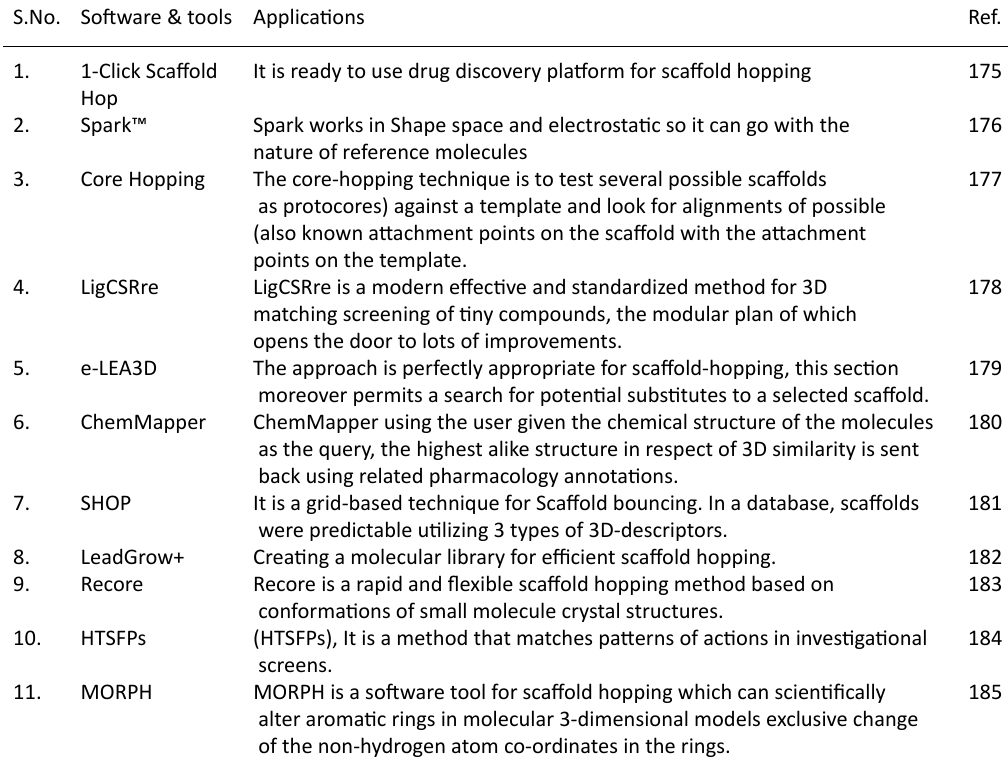
Table 5. List of Software and tools for scaffold hopping S.No. Software & tools